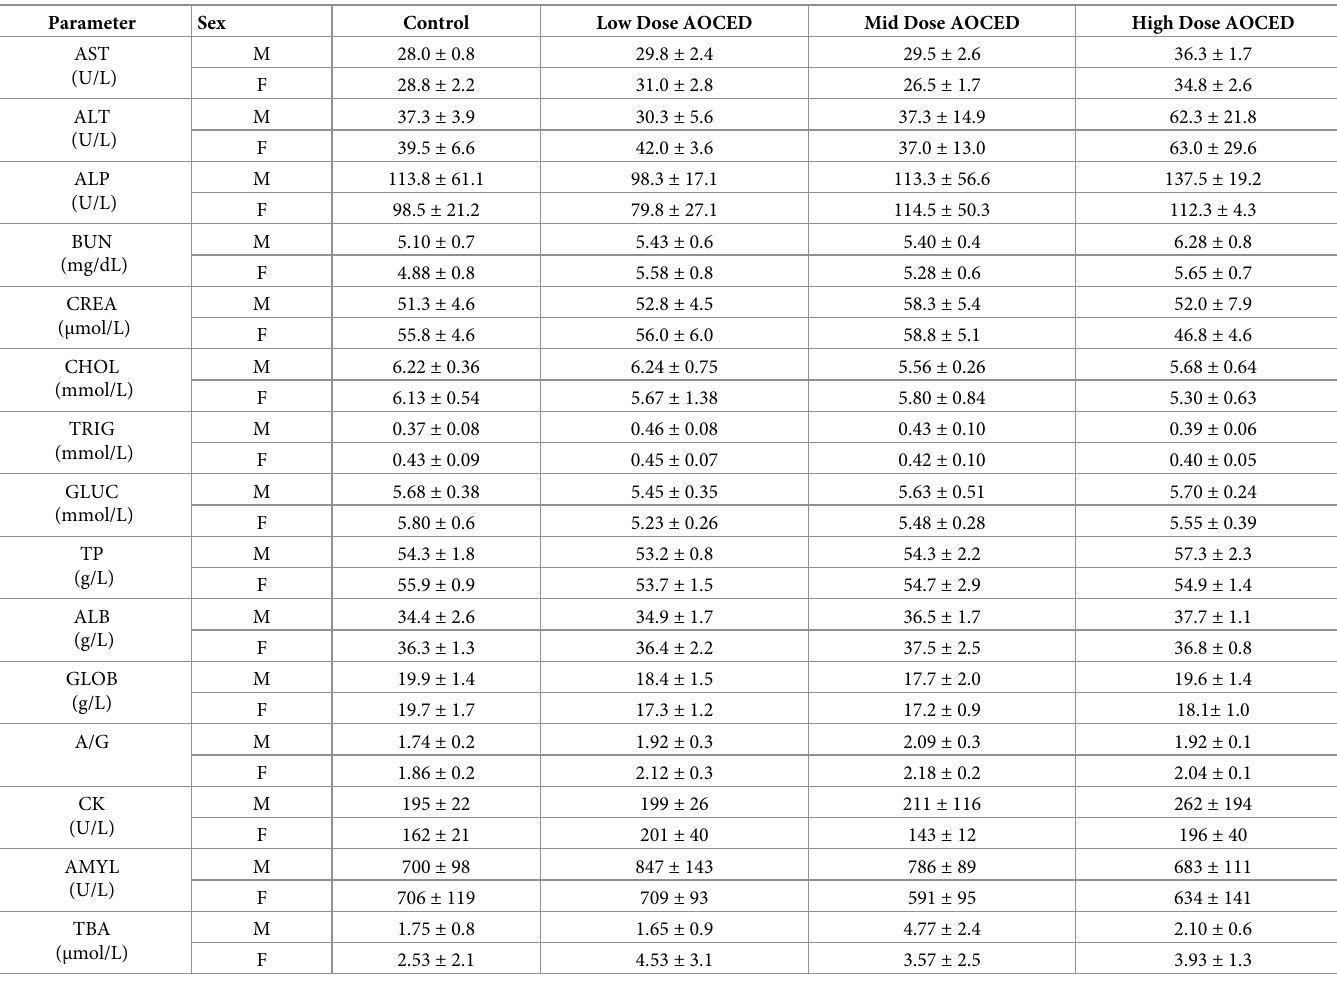
Table 6. Clinical chemistry values at the study completion (PPD 224) following AOCED exposure starting in utero until puppies reach 6 months after weaning.